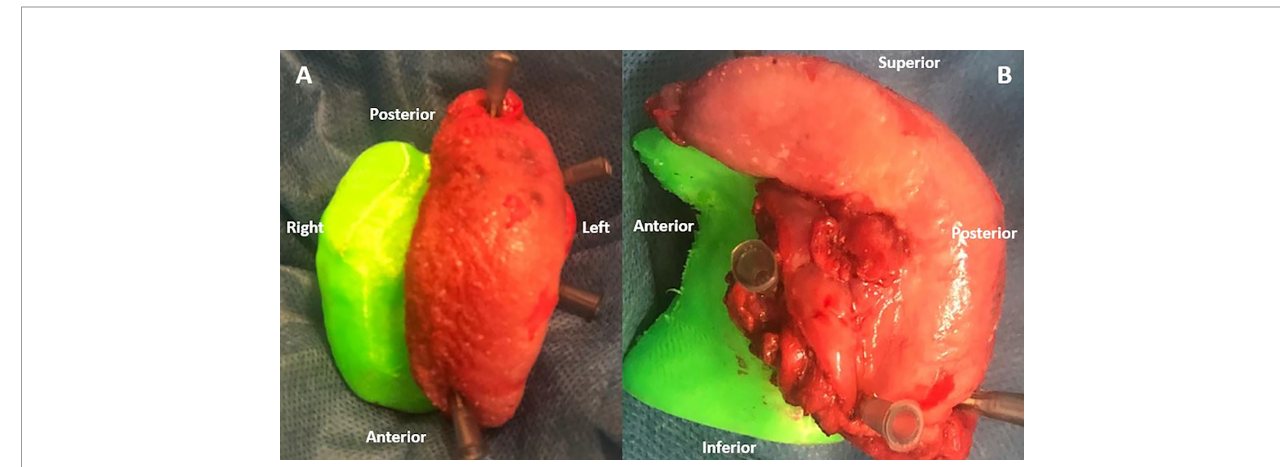
FIGURE 3 | Superior (A) and Lateral (B) views of surgical specimen of a left hemiglossectomy oriented on a 3D-printed model of the protuted tongue and the fl oor of the mouth obtained from the staging MRI of the